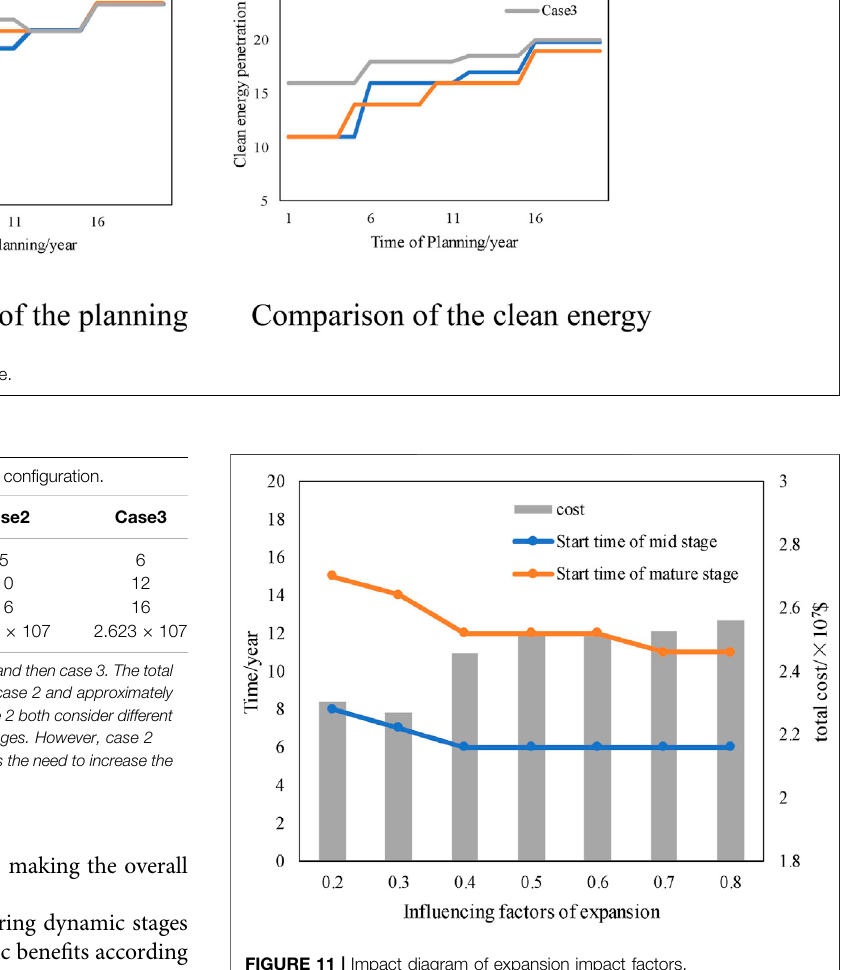
FIGURE 11 | Impact diagram of expansion impact